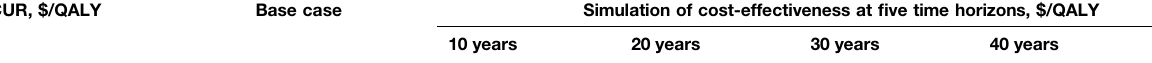
TABLE 7 | Results of scenario analysis on time